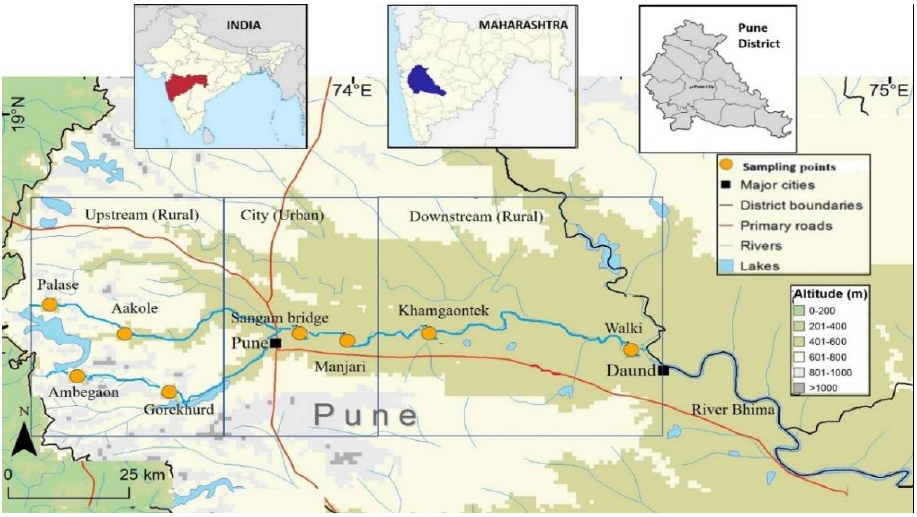
Figure 1. Distribution of sampling points across Mula and Mutha river.